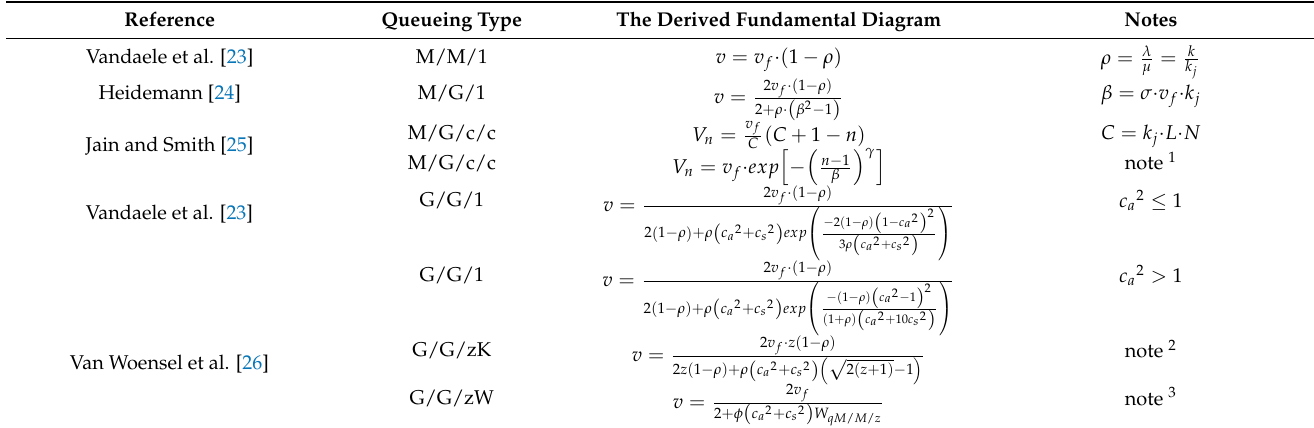
Table 2. Typical queueing-based fundamental diagrams.